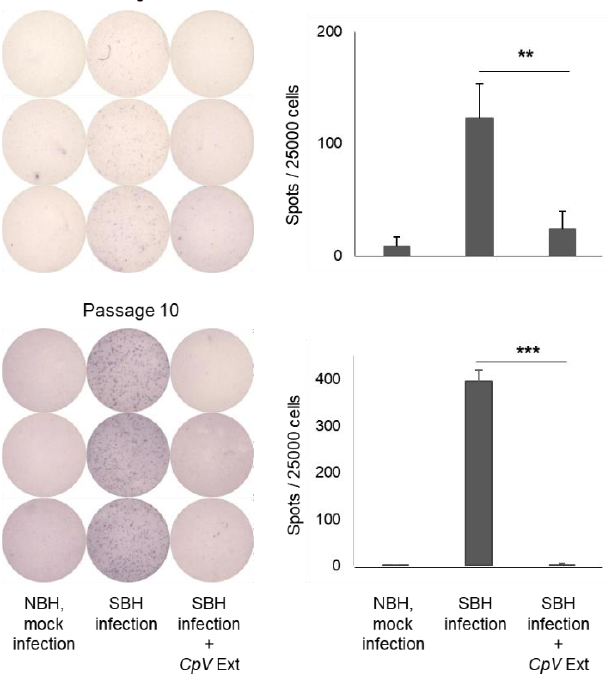
Figure 7. Reduction in prion infectivity by CpV extract. SSCA at passages 4 and 10 post-prion infection was used for PrP Sc -positive spot counts. **, p = 0.008; ***, p = 0.00001. NBH, normal brain homogenate (prepared from mice with no prion infection); SBH, sick brain homogenate (prepared from ill mice at the terminal stage of disease due to prion infection).